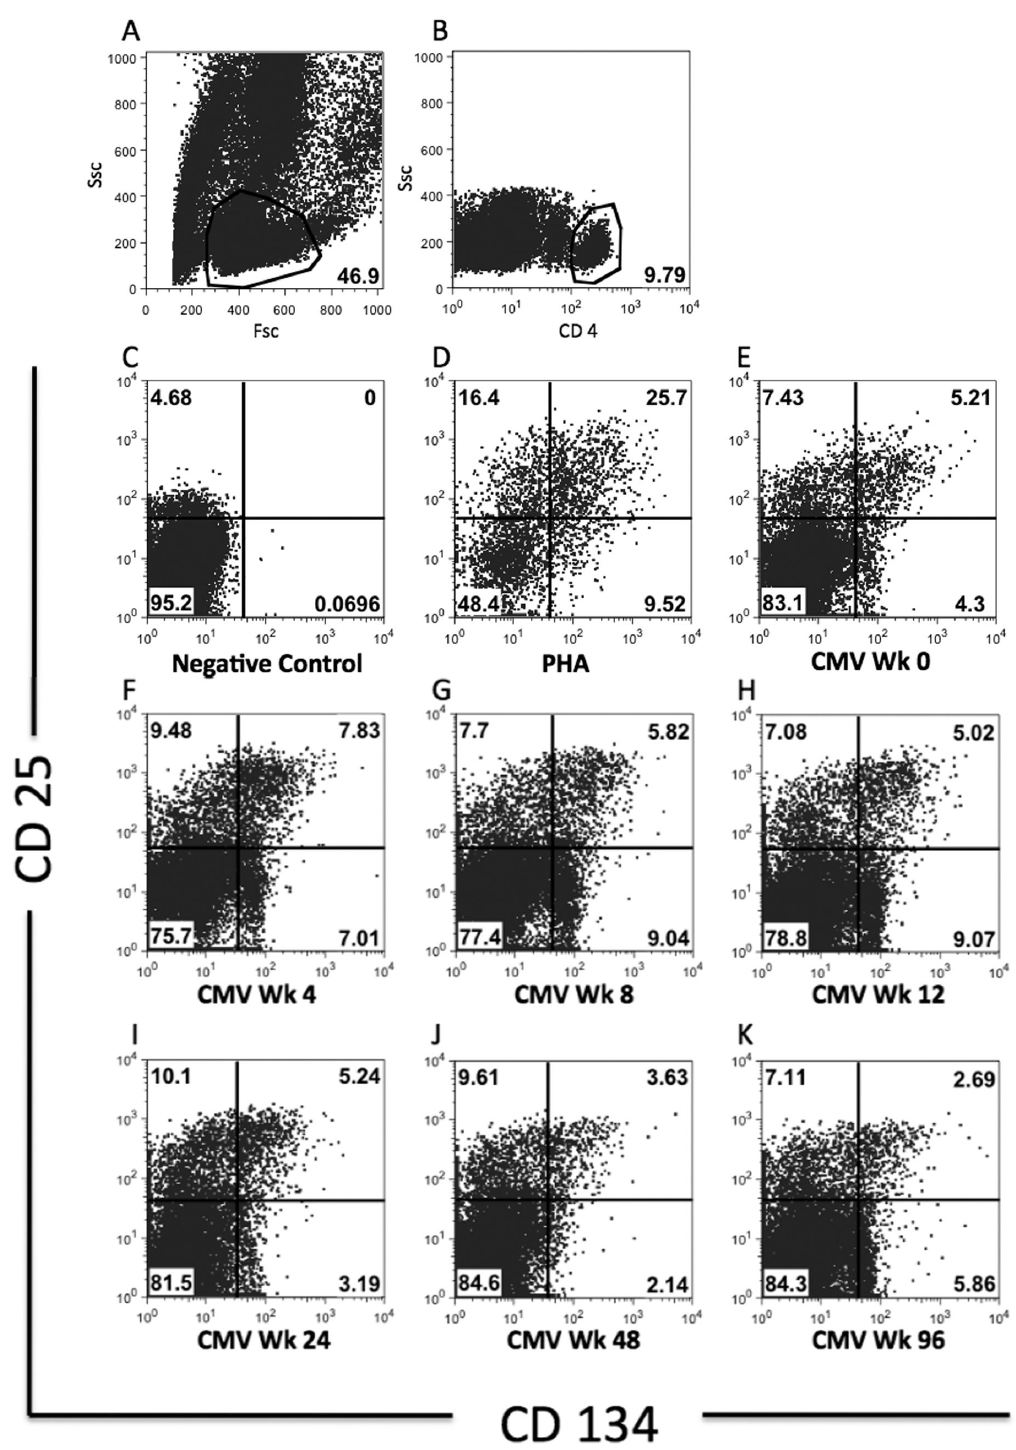
Figure 1. Gating strategies for CMV-SP-CD4 T cells. All flow cytometry plots are from a single subject of the RESTORE study. Lymphocytes were identified using forward and side scatter (Figure 1A), followed by gating on CD4+ T cells (Figure 1B). Gates for CD25+ and CD134+ cells were placed based on comparison with negative control (Figure 1C) and PHA positive control (Figure 1D) to include cells highly co-expressing CD25 and CD134. A representative example of the dynamics of responses to CMV antigens over 96 weeks of follow-up in a RESTORE subject (Figure 1E-K). doi: 10.1371/journal.pone.0077479.g001 PLOS ONE |